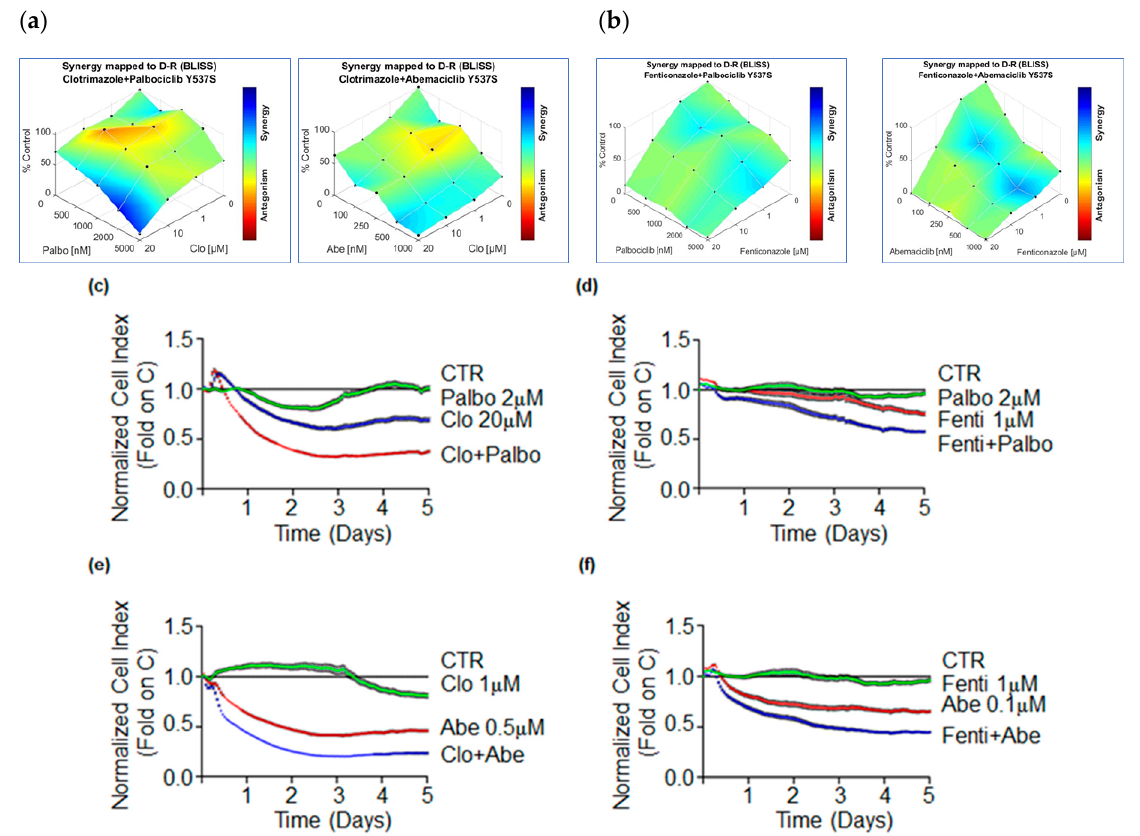
Figure 8. Clotrimazole and fenticonazole synergic effects with palbociclib and abemaciclib in Y537S cells. Synergy map of 5 days treated Y537S cells with different doses of clotrimazole (Clo) and palbociclib (palbo) or abemaciclib (Abe) ( a ), left and right panels, respectively) or of fenticonazole and palbociclib (palbo) or abemaciclib (Abe) ( b ), left and right panels, respectively). Growth curves in Y537S cells showing the synergic effect of each combination of compounds with selected doses are shown in ( c – f ). For details, please see the material and methods